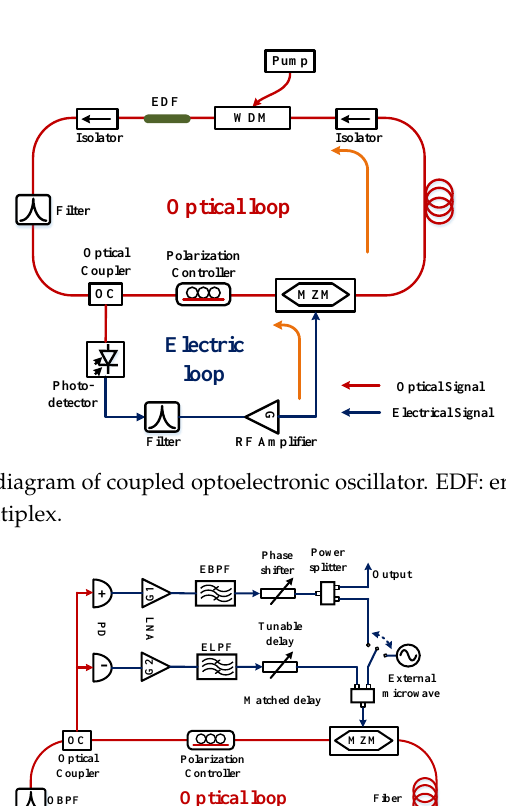
4 of 13 Figure 2. The schematic diagram of dual-loop optoelectronic oscillator. EOM: electro-optical modulator. PD: photodetector. EA: electronic amplifier. PS: phase shifter. PC: power coupler. Optical Coupler Bias-T